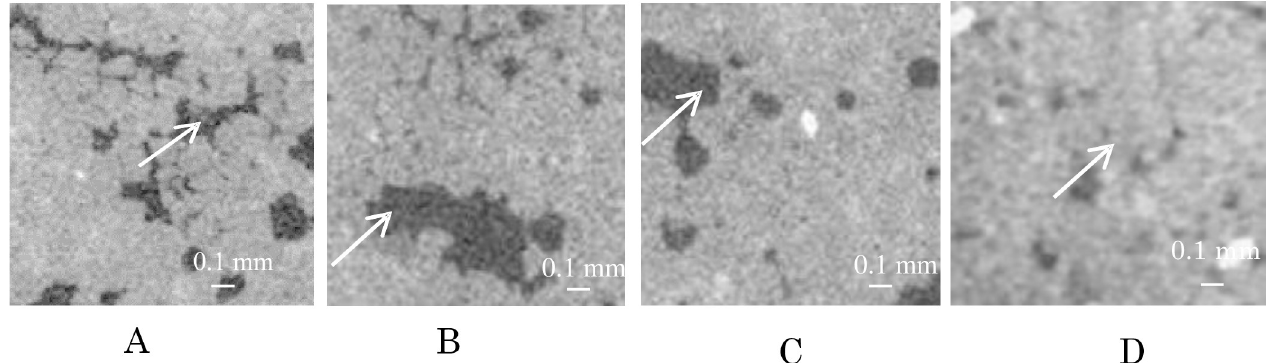
Fig 2. Amorphous substances (black) and disaggregation in amorphous substances in new mortar samples. A. Amorphous substance of sample A (Nittetsu cement). B. Amorphous substance of sample B (Extracted cement). C. Amorphous substance of sample C (Extracted cement + AE water reducing agent). D. Amorphous substance of 120